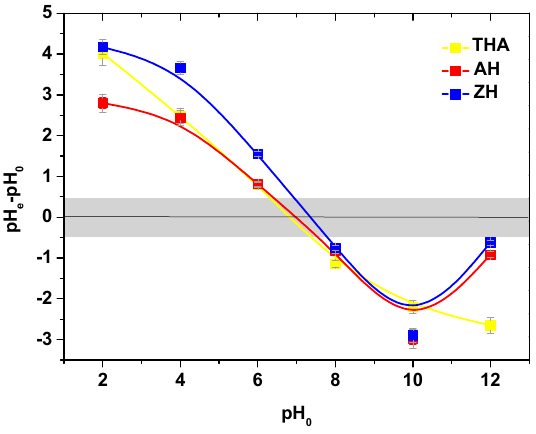
Figure 10. Point of zero charge of THA, AH and